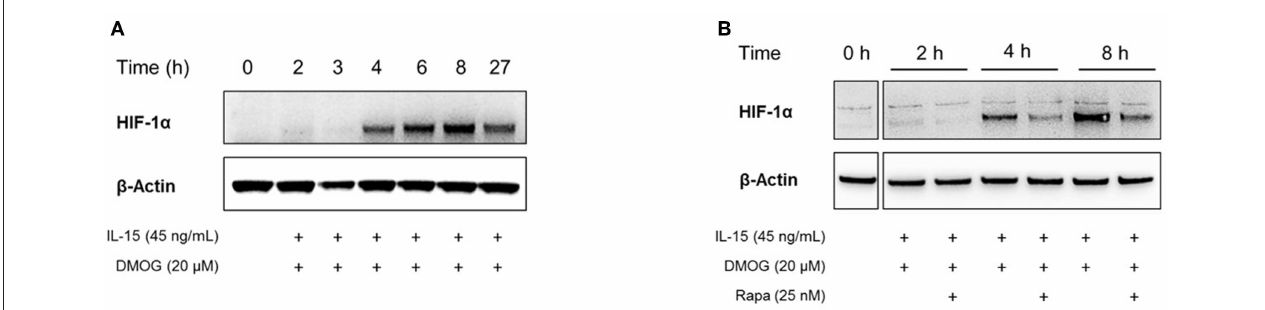
FIGURE 2 | In the presence of DMOG, stimulation of NK cells with IL-15 induces the accumulation of HIF-1 α protein. Whole cell extracts were used for immunoblotting of HIF-1 α . Equal gel loading was confirmed by β -actin expression. (A) After preincubation under normoxia for 16 h, NK cells were treated with IL-15 and DMOG for indicated additional time periods. (B) In addition to IL-15 and DMOG, NK cells were treated with rapamycin (Rapa), which reduces HIF-1 α protein